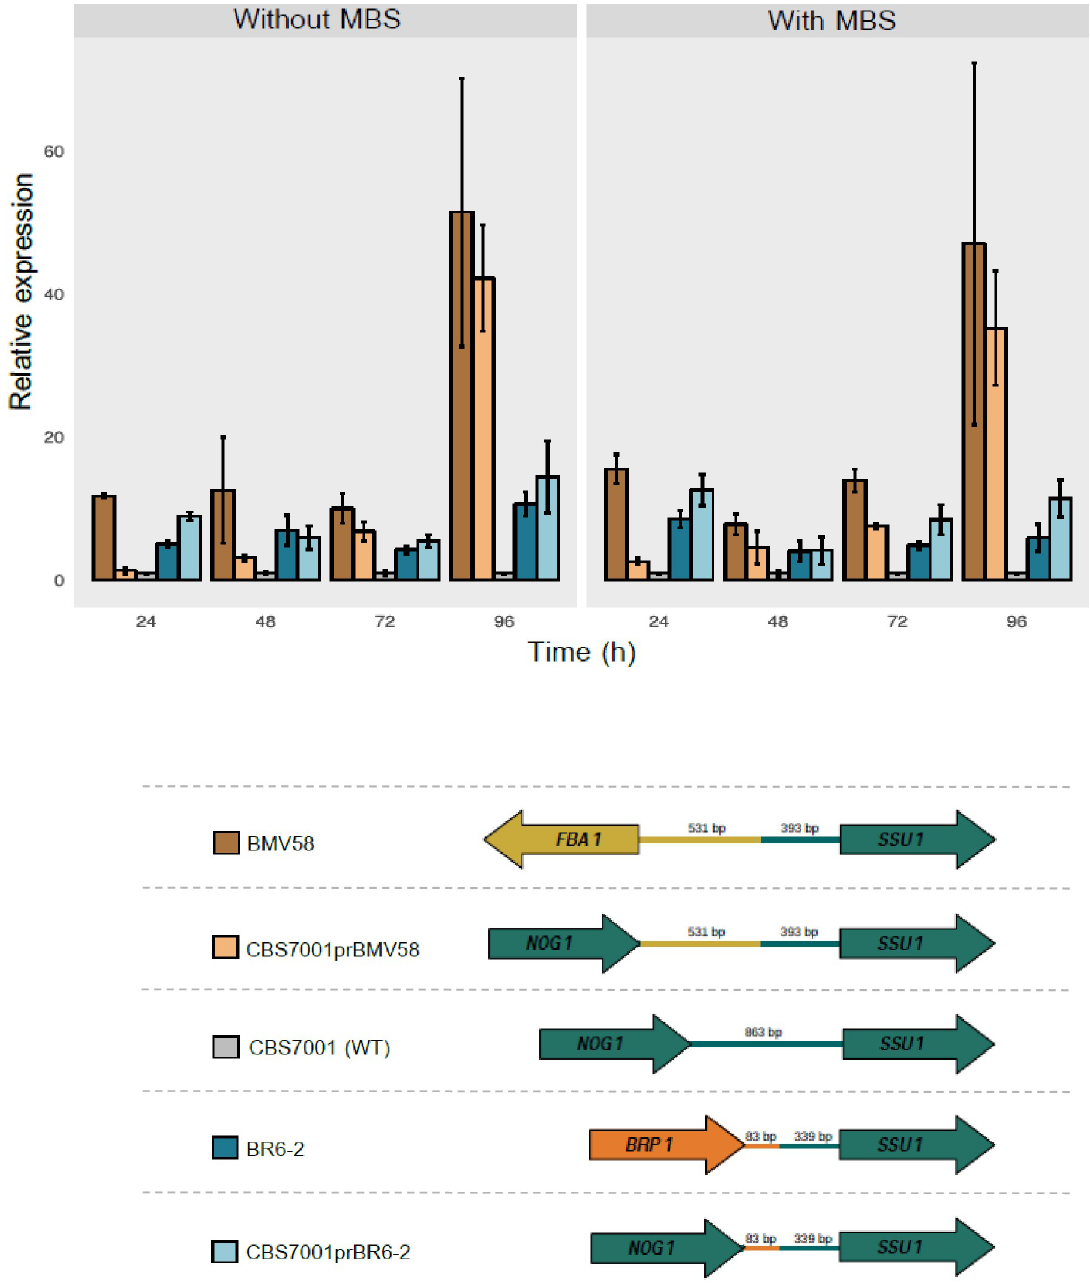
Fig 3. Relative SSU1 expression in S . uvarum wild type and edited strains grown in a fermentation experiment. Expression of SSU1 gene was studied during wine fermentation in synthetic must with or without sub lethal sulfite (MBS) concentration (15 mg/l) for a strain with the wild type chromosomes (CBS7001), a strain with the VII XVI translocation (BMV58), a strain with the VII XVI translocation (BR6-2), a modified version of the CBS7001 type strain with the BM58 SSU1 promoter (CBS7001pBM58) and a modified version of the CBS7001 type strain with the BR6-2 SSU1 promoter (CBS7001pBR6-2). A schematic representation of the different SSU1 promoters is presented for each strain. Daily samples were taken until day four and, after mRNA extraction, SSU1 gene expression was quantified by qPCR. Two constitutive genes ( ACT1 and RDN18 ) were used to normalize qPCR data. All expression measures were relativized to the SSU1 expression in the CBS7011 wild type strain grown under the same fermentation